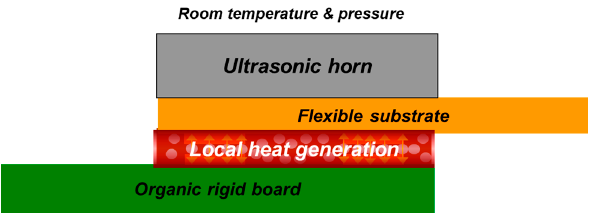
Figure 10. A schematic of ultrasonic bonding.